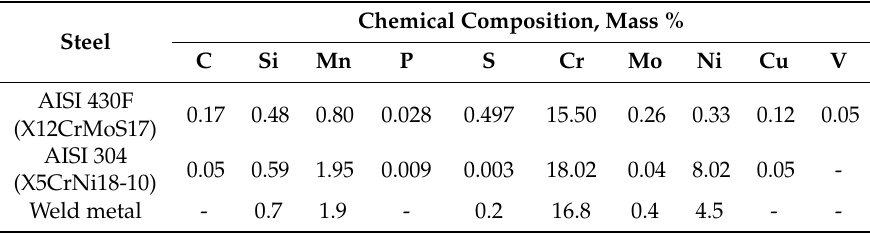
Table 1. Chemical composition of base metals (OES) and weld metal (EDS).